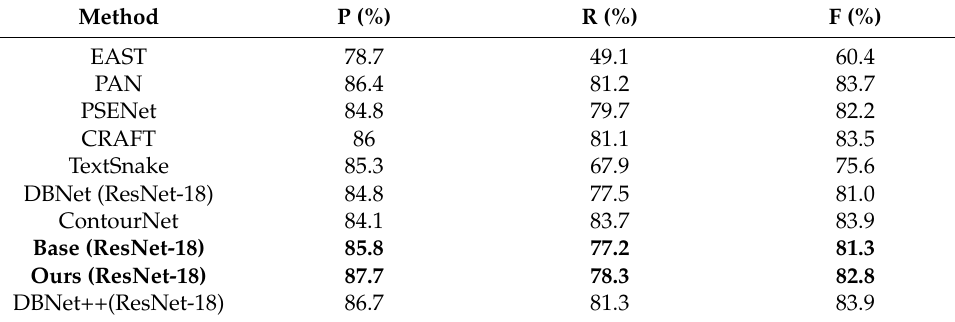
Table 4. Detection results on the CTW1500